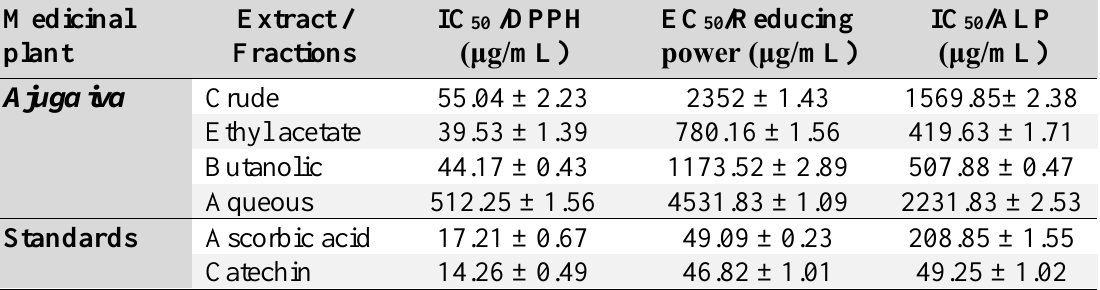
Table 2. Antioxidant activities for extracts and